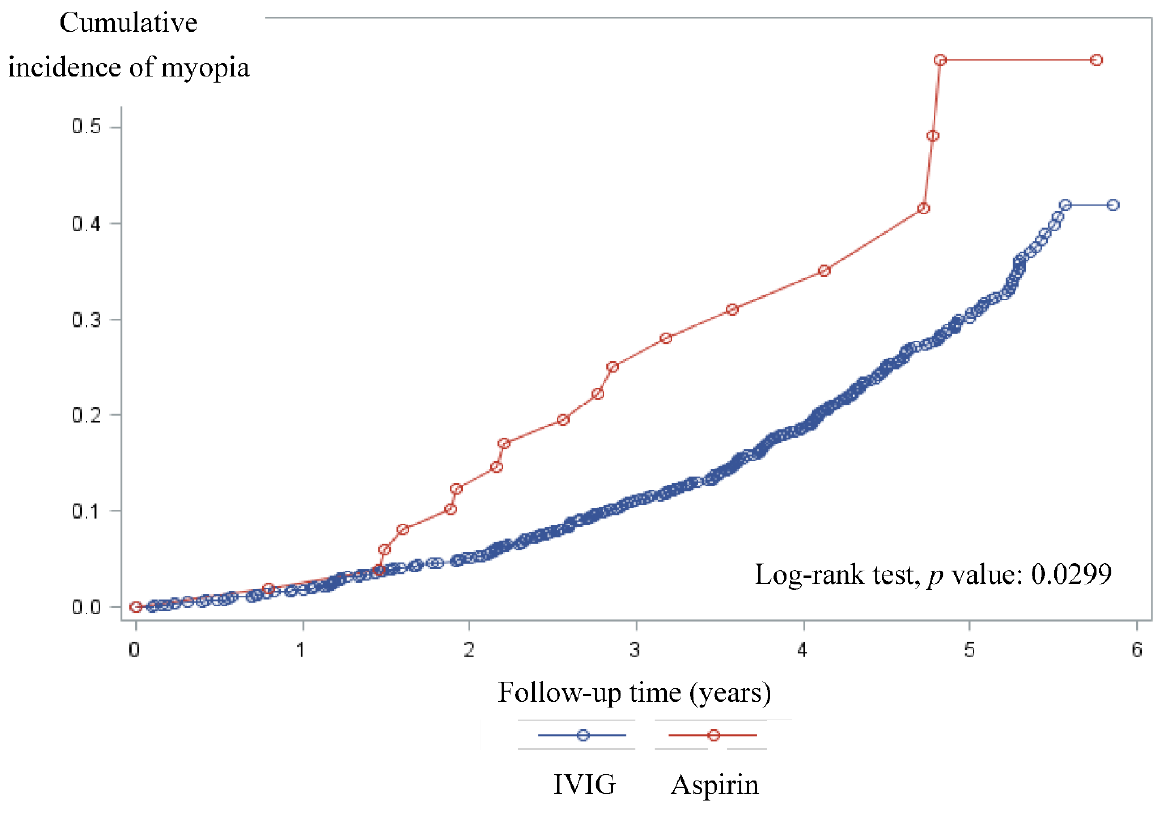
Figure 2. Cumulative incidence curves of myopia for Kawasaki disease groups. A comparison of the crude adjusted hazard ratio (HR) of myopia between the two groups indicated that the incidence of myopia in the aspirin group was significantly higher (Table 2) than in the IVIG group. Male gender (boys) had higher risk of myopia than female gender (girls) in both aspirin group ( p < 0.0001) and IVIG group ( p < 0.01). The